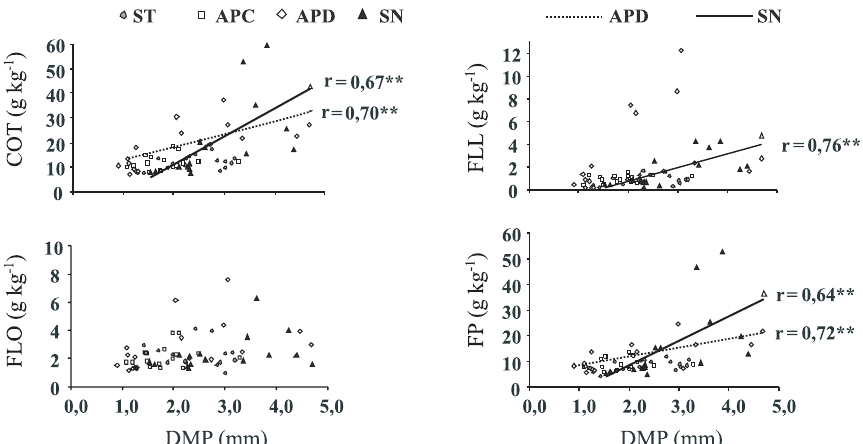
Figura 2. Correlação entre o diâmetro médio ponderado (DMP) dos agregados de um Planossolo sob diferentes sistemas de manejo e o teor de carbono orgânico total (COT) e das frações leve livre (FLL), leve oclusa (FLO) e pesada (FP) da matéria orgânica do solo. ** Significativo < 1 %. ST: Sistema tradicional de cultivo: um ano de arroz irrigado por alagamento (preparo convencional), seguido de dois anos de pousio; APC: Sistema de cultivo contínuo de arroz irrigado por alagamento (preparo convencional); APD: Sucessão de azevém x arroz irrigado por alagamento (plantio direto); e SN: Solo sob vegetação nativa (sem